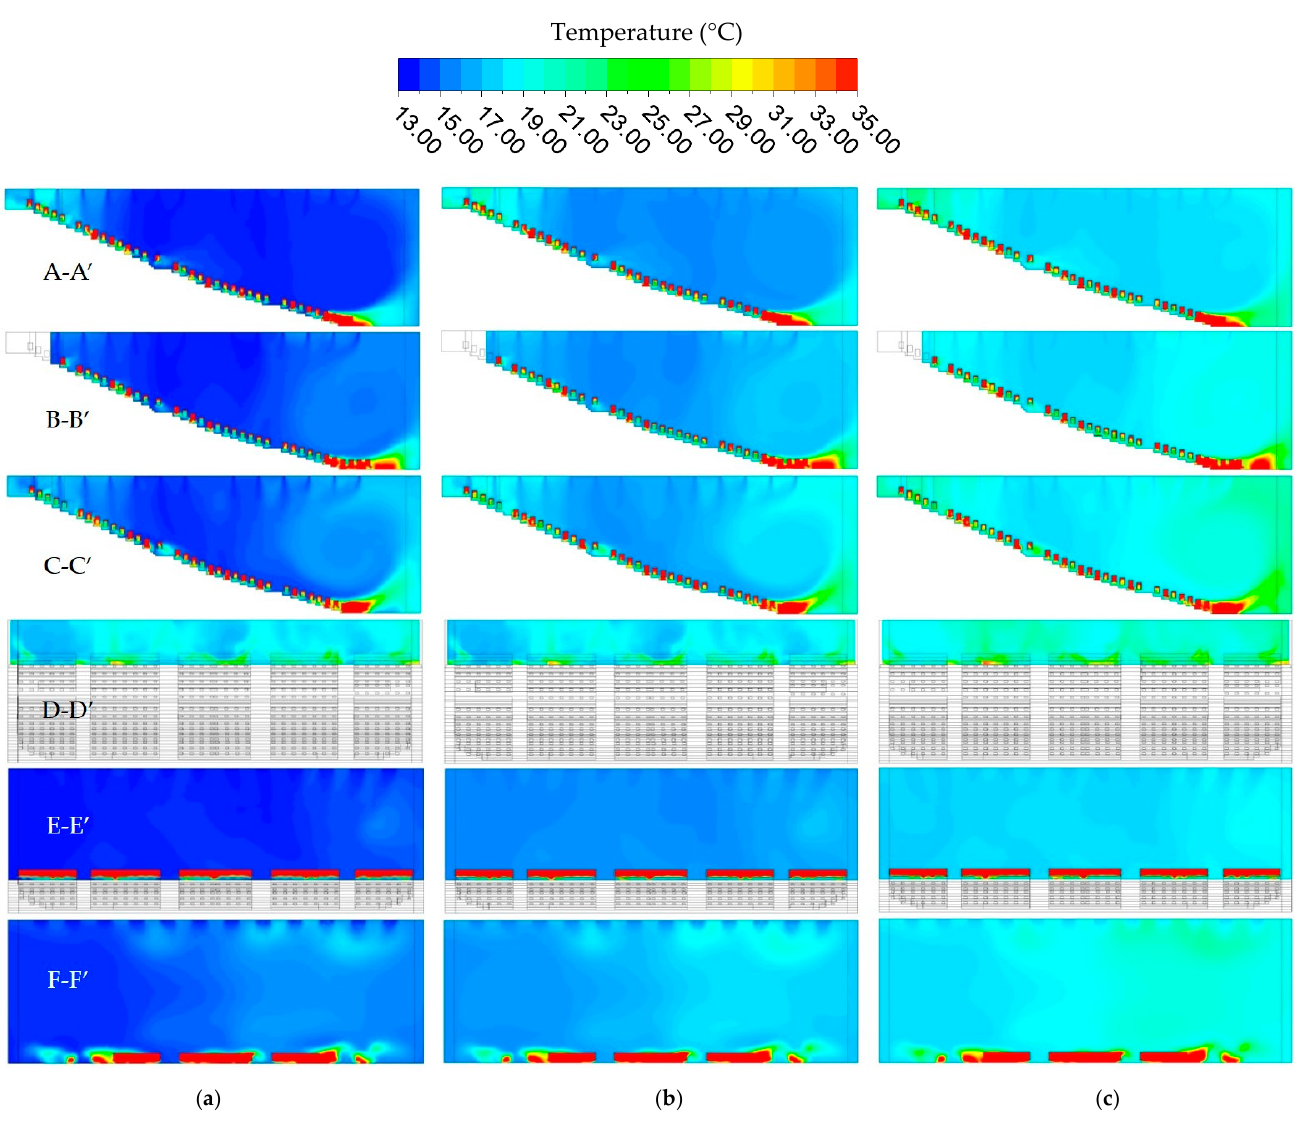
Figure 4. Temperature distribution results in different temperature and air velocity at 2 m/s. ( a ) temperature setting: 13 °C, ( b ) temperature setting: 15 °C, and ( c ) temperature setting: 17 °C.